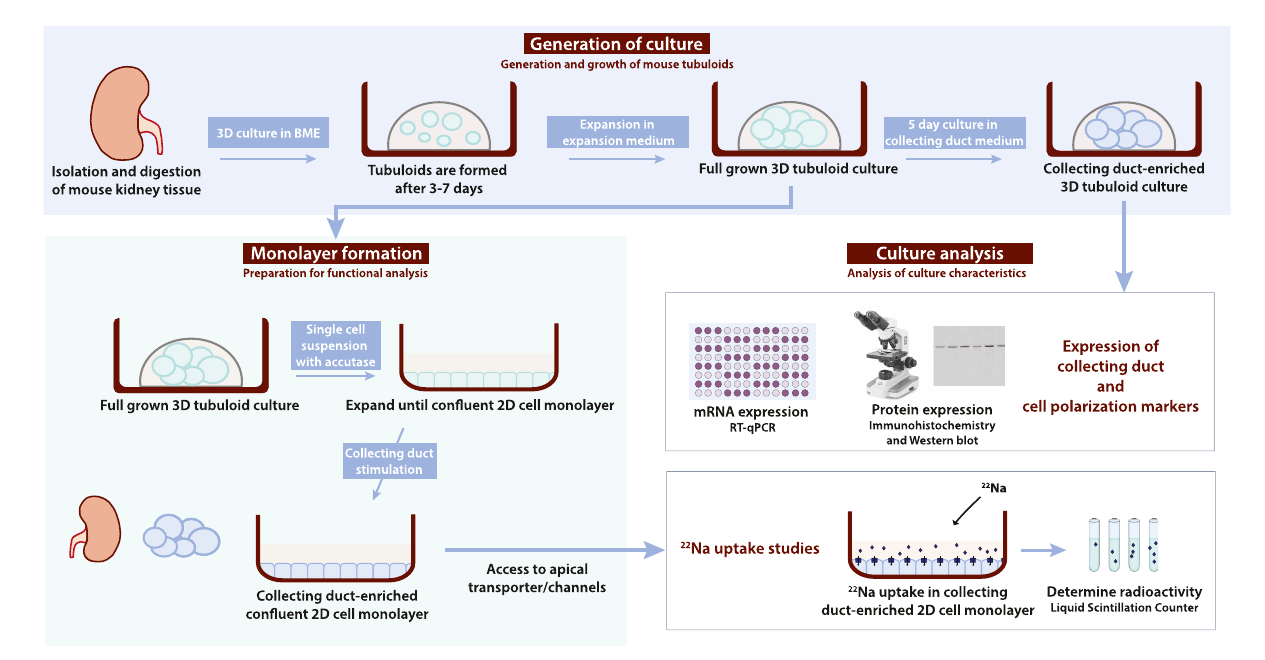
FIGURE 1 Flowchart depicting mouse tubuloid generation, monolayer formation and analysis protocol. Tubuloids are formed from digested C57BL/6 mouse kidney tissue within 7 days of culture inbasement membrane extract (BME) with expansion medium (EM). Subsequentexpansion of tubuloids inEM was done to obtain a full-grown 3D tubuloid culture. This full-grown tubuloid culture can be enriched for the CD with 5 days of culture in CD medium. A CD-enriched tubuloid culture can be analyzed with RT-qPCR for mRNA expression or immunohistochemistry and/or Western blot analysis for protein expression to con fi rmexpressionofCD(e.g.,AQP2andsubunitsofENaC)and/orcellpolarization(e.g.,ZO-1,E-cadherin,andNa + /K + -ATPase)markers.Alternatively,afull- grown 3D tubuloid culture can be used for 2D monolayer formation. First, a tubuloid single cell suspension is obtained with accutase treatment from thefull- grown 3D tubuloid culture. Subsequently, the single cell suspension is seeded into a normal cell culture plate and grown to a con fl uent 2D cell monolayer using EM. Once acon fl uent 2D cell monolayer isformed, it canbe stimulated to form aCD-enriched con fl uent 2Dcell monolayer. Growingtubuloids ina 2D cellmonolayerallowsforaccesstoapicaltransporters/channels(e.g.,ENaC)forfunctionalassays.CD-enrichedcon fl uent2Dcellmonolayerscanbeusedfor functional 22 Na uptake studies, where radioactive uptake is determined with a liquid scintillation counter. BME; basement membrane extract, EM; expansion medium,3D;three-dimensional,CD;collectingduct,RT-qPCR;reversetranscription-quantitativePCR,AQP2;aquaporin2,ENaC;epithelialsodiumchannel, 2D;